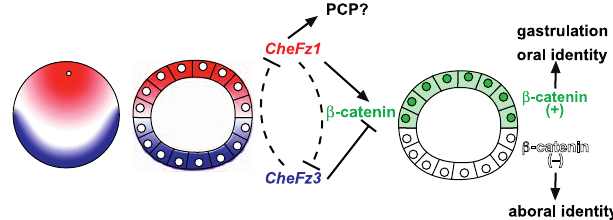
Figure 8. Model for Cnidarian Embryonic Patterning Initiated by Localised Maternal Frizzled RNAs CheFz1 (red) transcribed from animally localised RNA activates the canonical Wnt pathway to stabilise b -catenin (green) and so promotes development of oral fates (including gastrulation and endoderm formation). It may also play a role in the establishment of ectodermal polarity via PCP. CheFz3 (blue) transcribed from vegetally localised RNA spatially restricts canonical Wnt pathway activation by CheFz1, defining an aboral gene expression territory. The oral and aboral domains are reinforced by mutual downregulation of CheFz1 and CheFz3 (dotted lines), by mechanisms probably involving secondary signalling molecules. doi:10.1371/journal.pbio.0050070.g008 PLoS Biology |